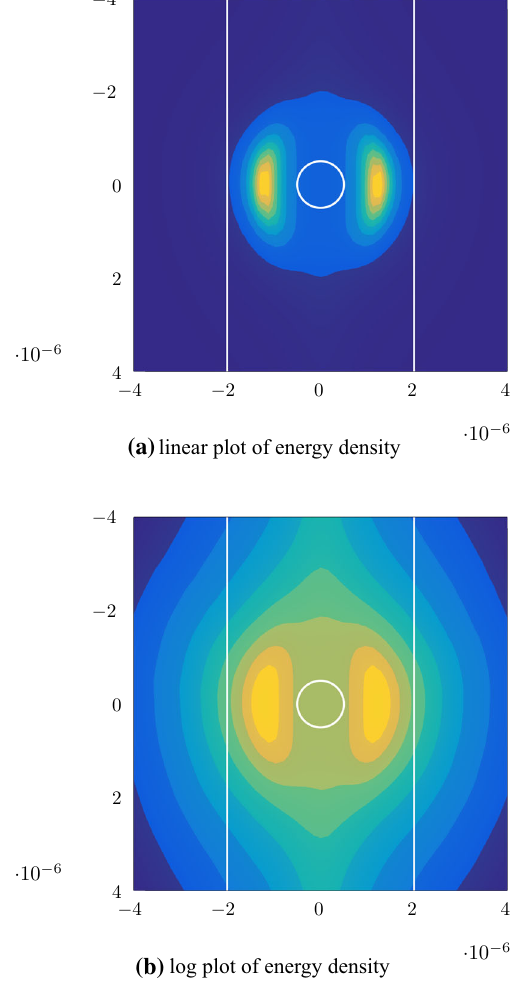
Fig. 7 The white lines represent a 4 µ m Casimir cavity, and the circle representsthe1 µ mpillarlocatedatthemidplaneofthecavity.Panel( a ) shows the linear 2D plot of the energy density and panel ( b ) shows the log2Dplot.Thebrightyellowregionsshowtheimpactofthepresenceof the pillar on the energy density, and the log plot shows that the pillars do not self-screen themselves from the background field gradient resulting from the presence of just the plates (lime-green color)